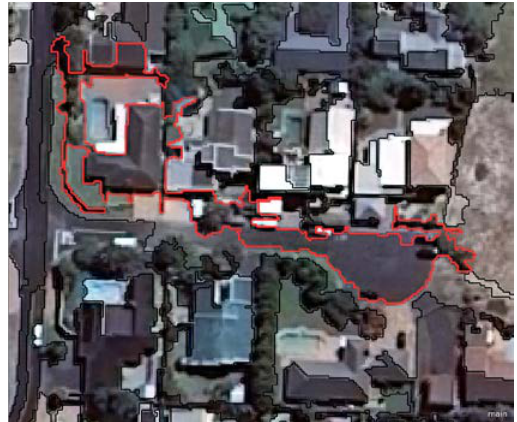
Figure 5c: Image segmentation (Level 1, scale: 100) The classes created were built-up area, road (for identifying the larger roads that were not included in the built-up area), bare ground or sand, vegetation and water. Samples were selected for each class, and the image was classified using the Nearest Neighbour (NN) method. A large scale parameter was chosen for classifying the image in order to adequately represent the large built-up areas. The following features were used in the NN